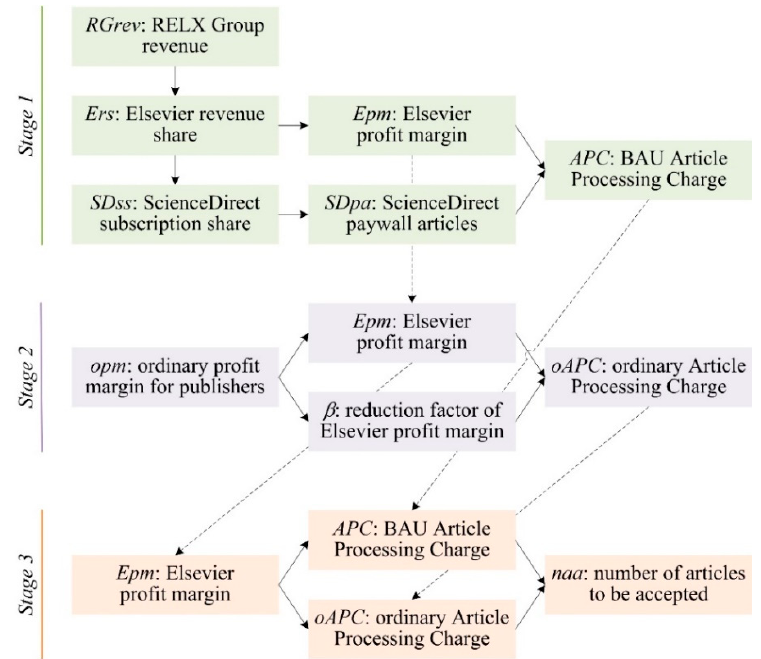
Figure 1. Three-stage analytical model.